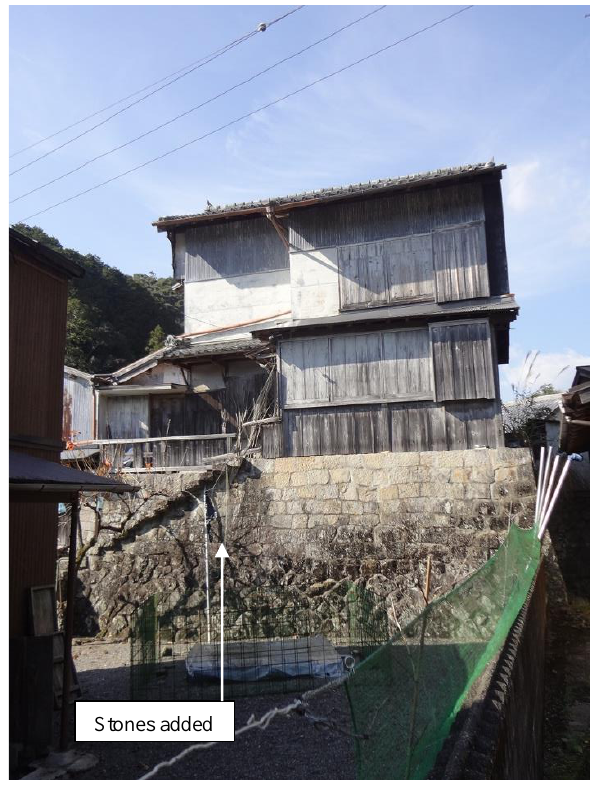
Figure 7. An Agariya still stands in the Hongu area in Hongu-cho.